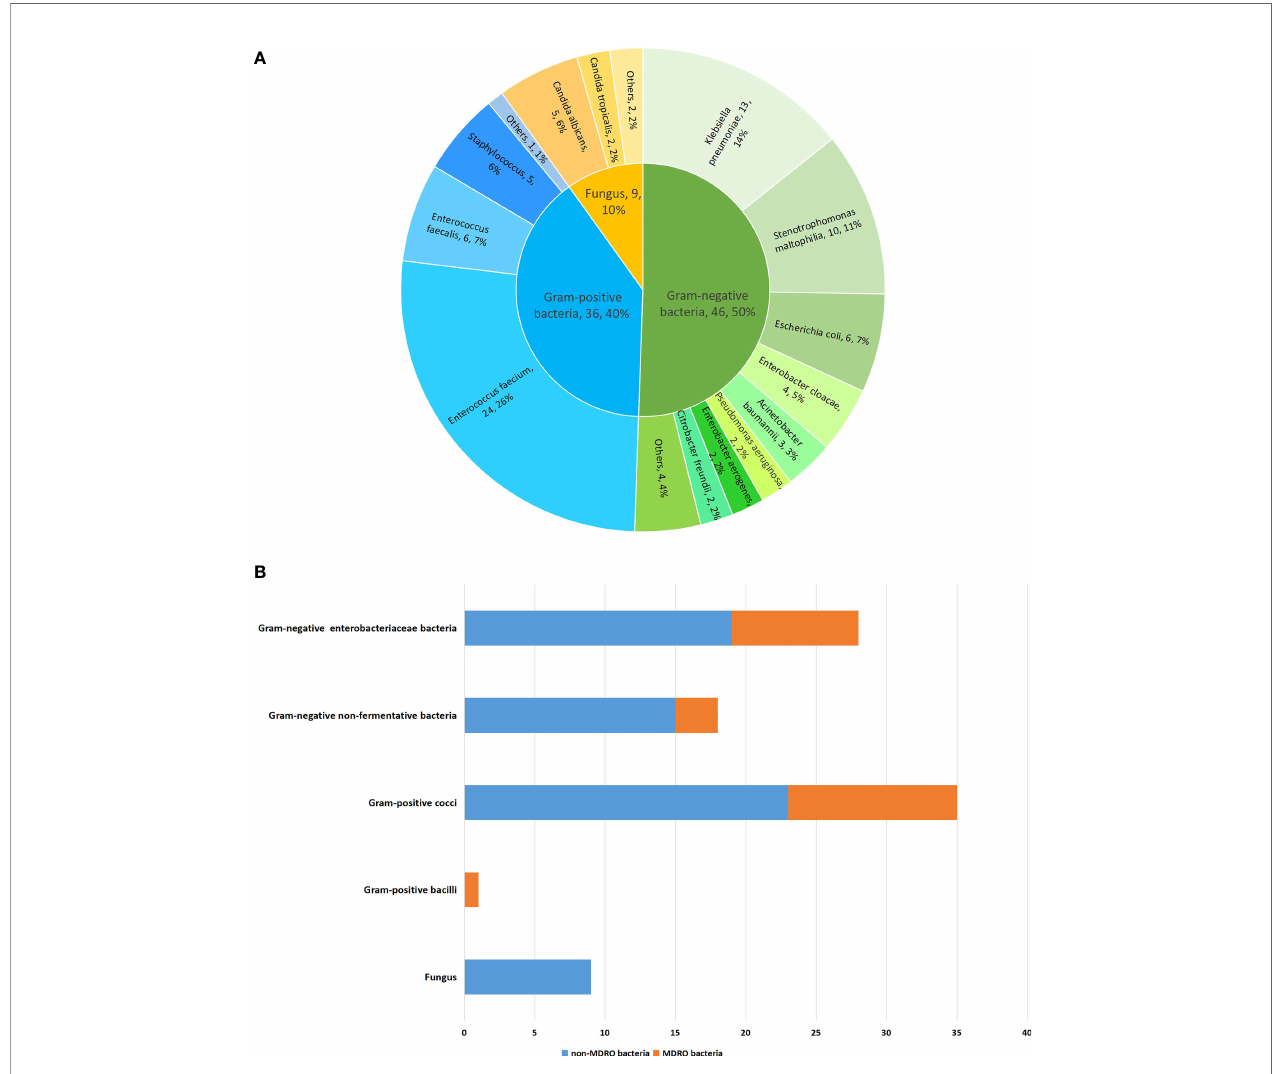
FIGURE 1 | The distribution and proportion of pathogenic bacteria in 98 patients with predicted severe acute gallstone pancreatitis. (A) The distribution and proportion of pathogenic bacteria. (B) The distribution and proportion of pathogenic bacteria by dividing of